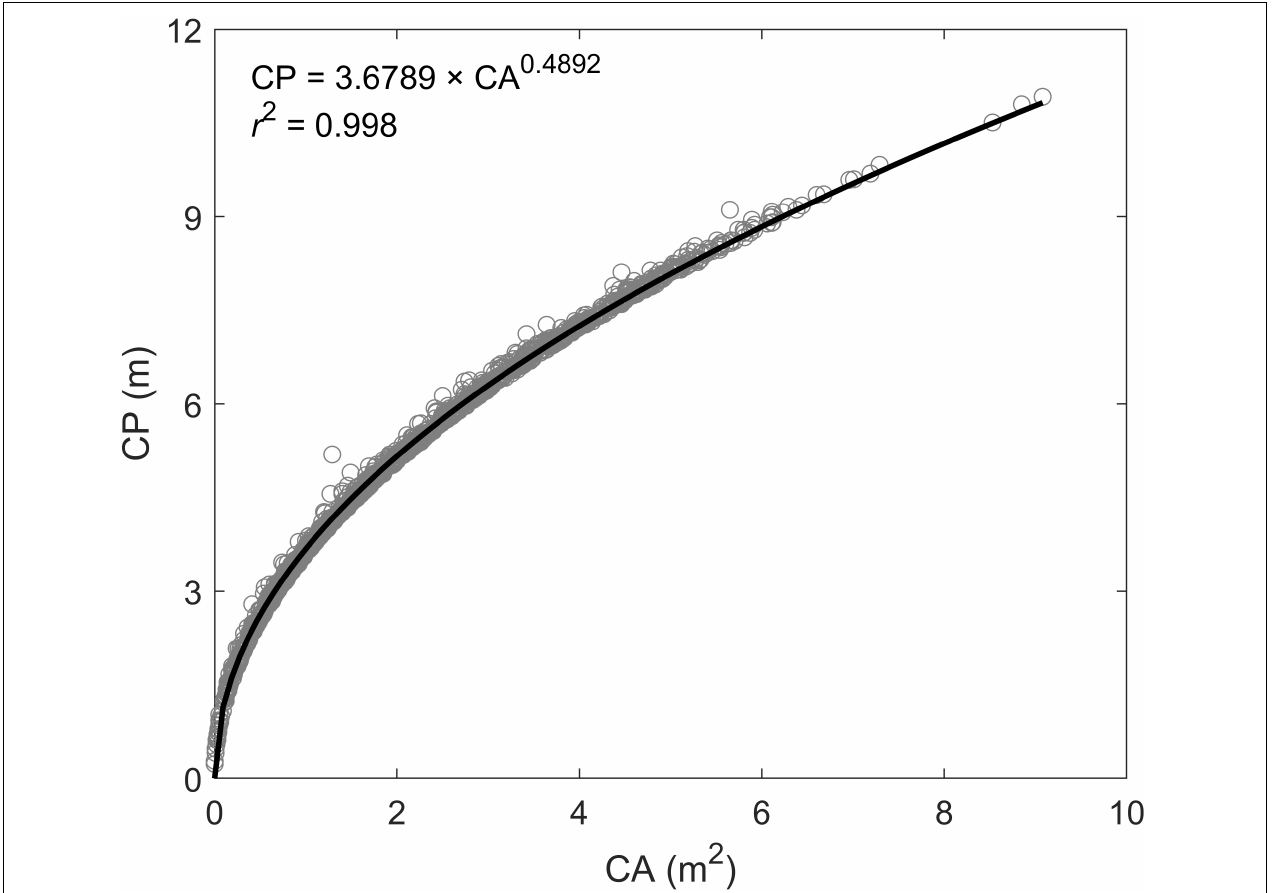
FIGURE 9 | The functional relationship between plant canopy area (CA) and canopy perimeter (CP) according to the UAV-based phenotyping measurements.